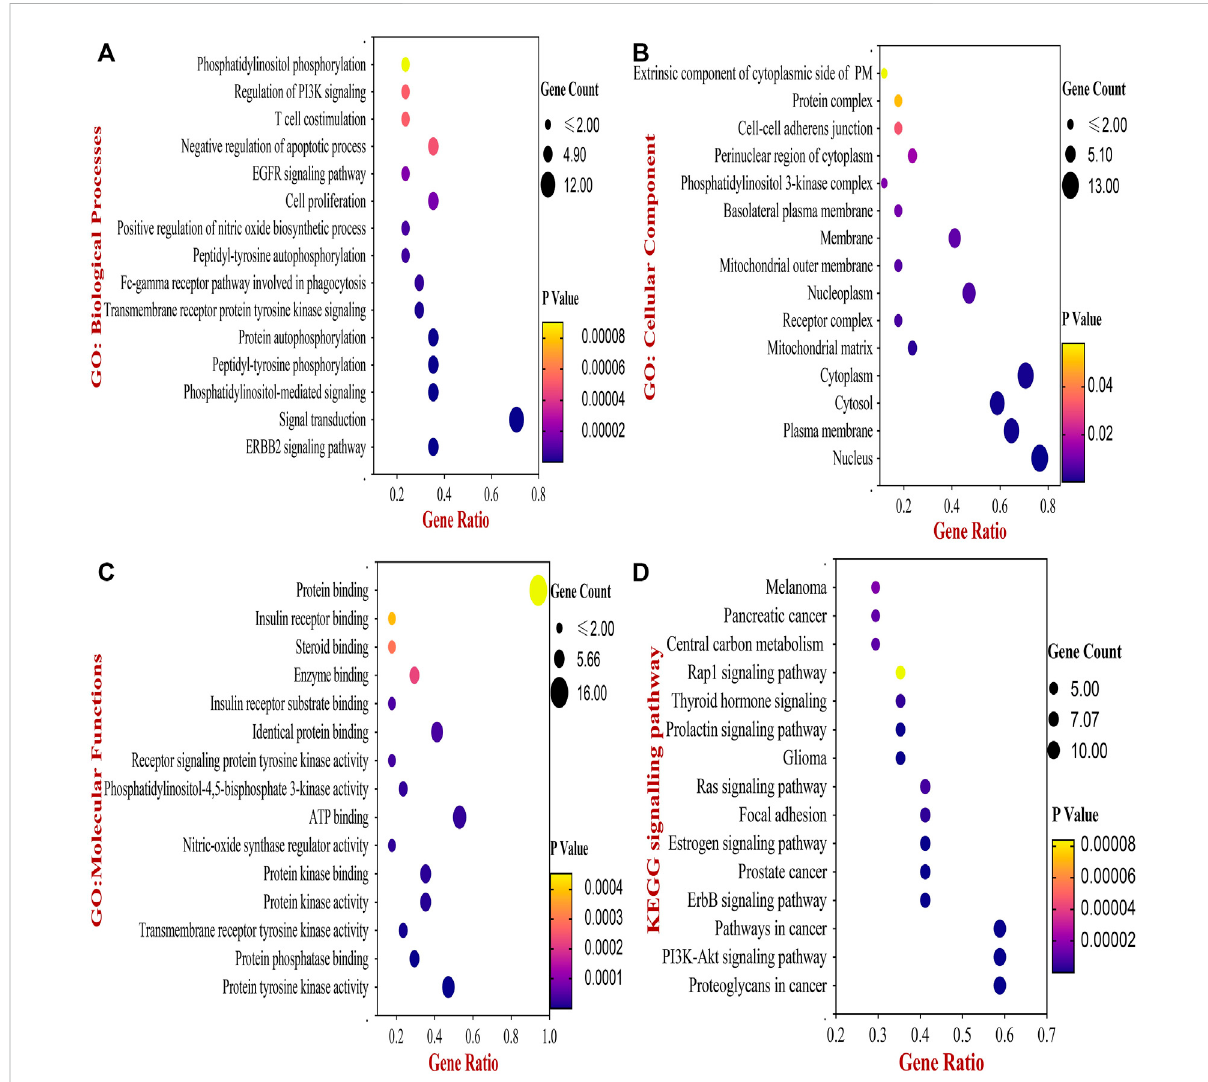
FIGURE 3 The Bubble chart of Gene Ontology (GO) and KEGG pathway analyses by DAVID database. (A) Top 15 GO- Biological Processes of 18- α GA targets. (B) Top 15GO- Cellular Component of18- α GAtargets. (C) Top 15GO- Molecular Functions; p -value < 0.05inall three GO terms (D) Bubble plot of Top 15 highly enrichedKEGG pathways of 18- α GAtargets, p -value < 0.05. Bubble size represents thenumber of enrichedgenes, and bubble color difference represents the signi fi cance of target gene